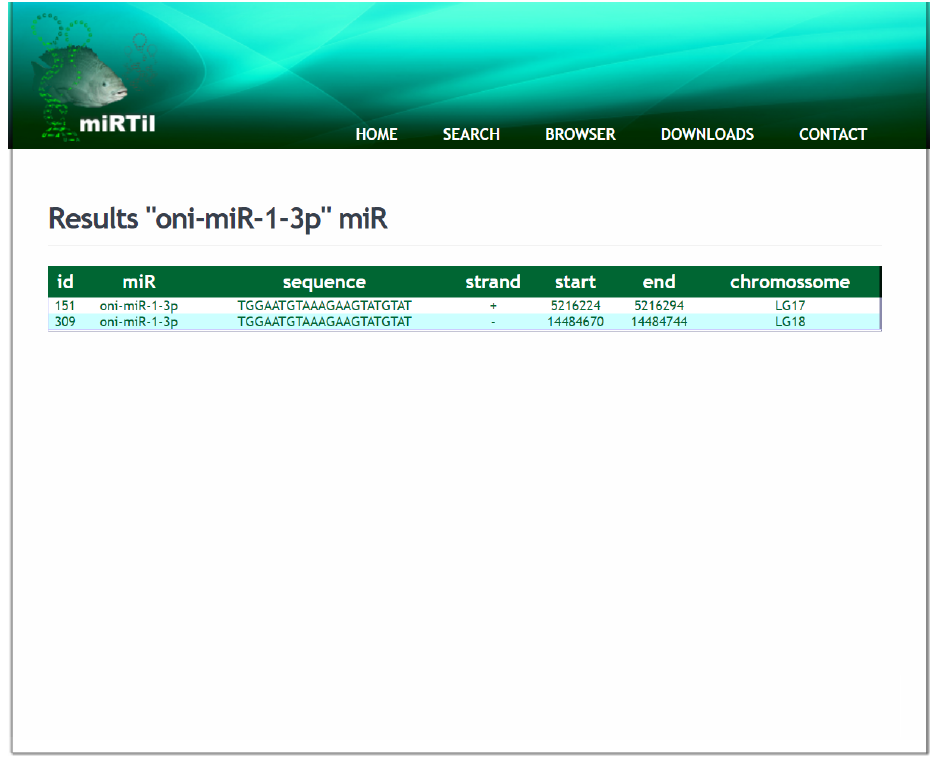
Figure 6. Simple miRNA information result. The page containing summarized miRNA information, such as miRNA ID, symbol, and mature sequence, as well as genomic location